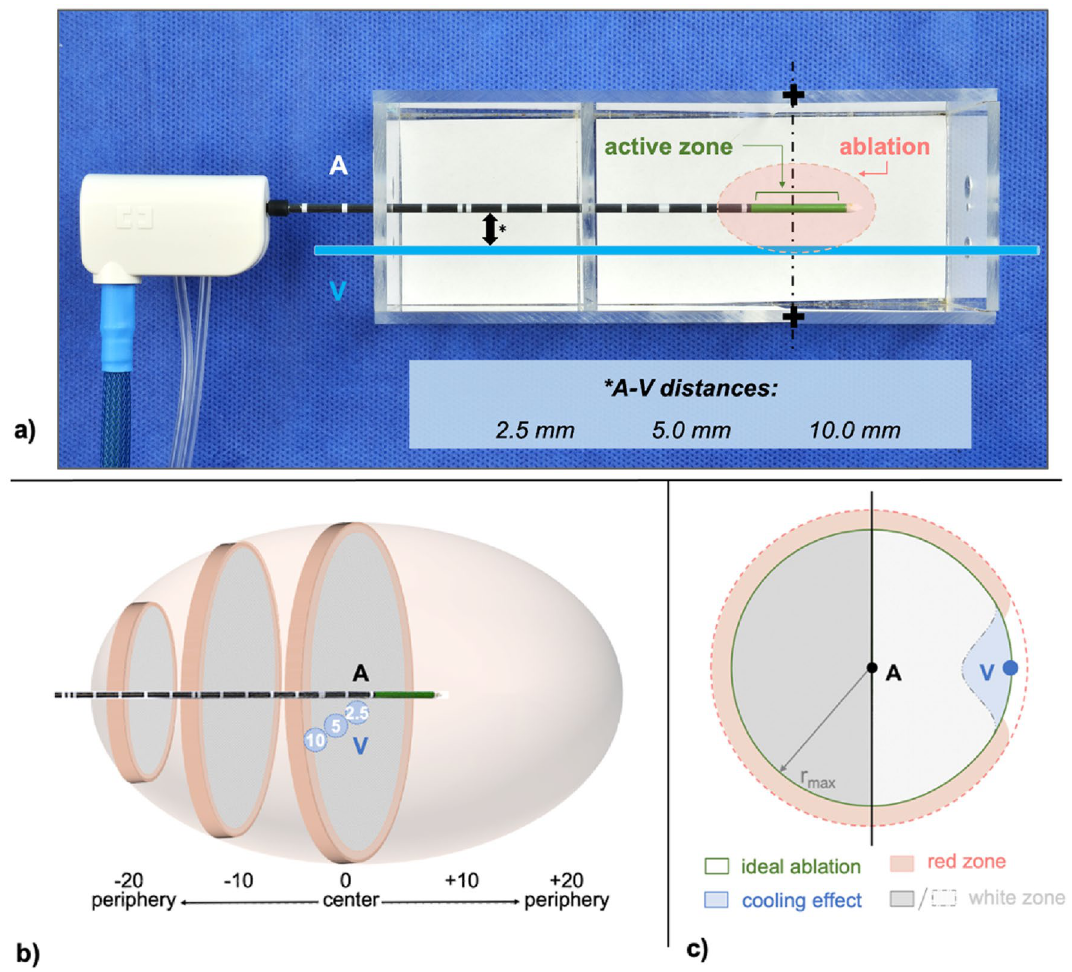
Figure 4. ( a ) Experimental setup using a custom-made aiming device allowing exact positioning of the microwave antenna (A) and glass tube, which simulated a natural vessel (V). Three different antenna to vessel (A–V) distances (*) were evaluated. All ablations were initially cut at the largest cross-sectional area (+) which is expected at the centre of the active zone of the microwave antenna. ( b ) Ablations were then bisected every 2 mm from the ablation centre (0). Each ablation half could be divided into a maximum of ten slices (− 20/+ 20). ( c ) Only the ablation half containing the vessel (V) was used for a quantitative analysis. Cooling effects were determined by subtracting the actual ablation area from an idealized ablation, which was calculated with the maximum ablation radius (r max ).